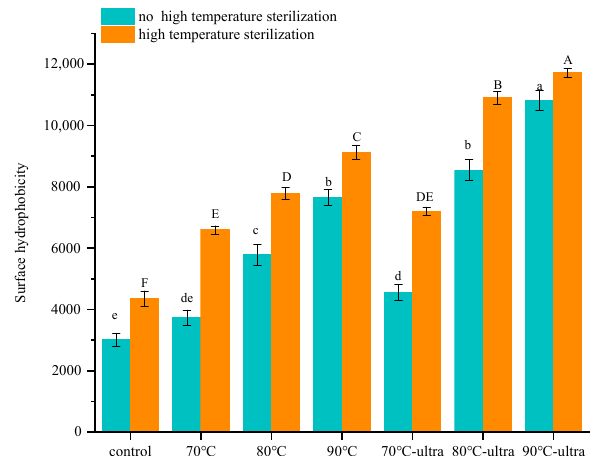
Figure 2. Surface hydrophobicity of different coconut globulin samples (ultra: 53 kHz, 40 w / l ; 70, 80 and 90 °C represent preheating for 20 min; high ‐ temperature sterilization: 135 °C for 60 s). Different letters indicate significant differences at p < 0.05.